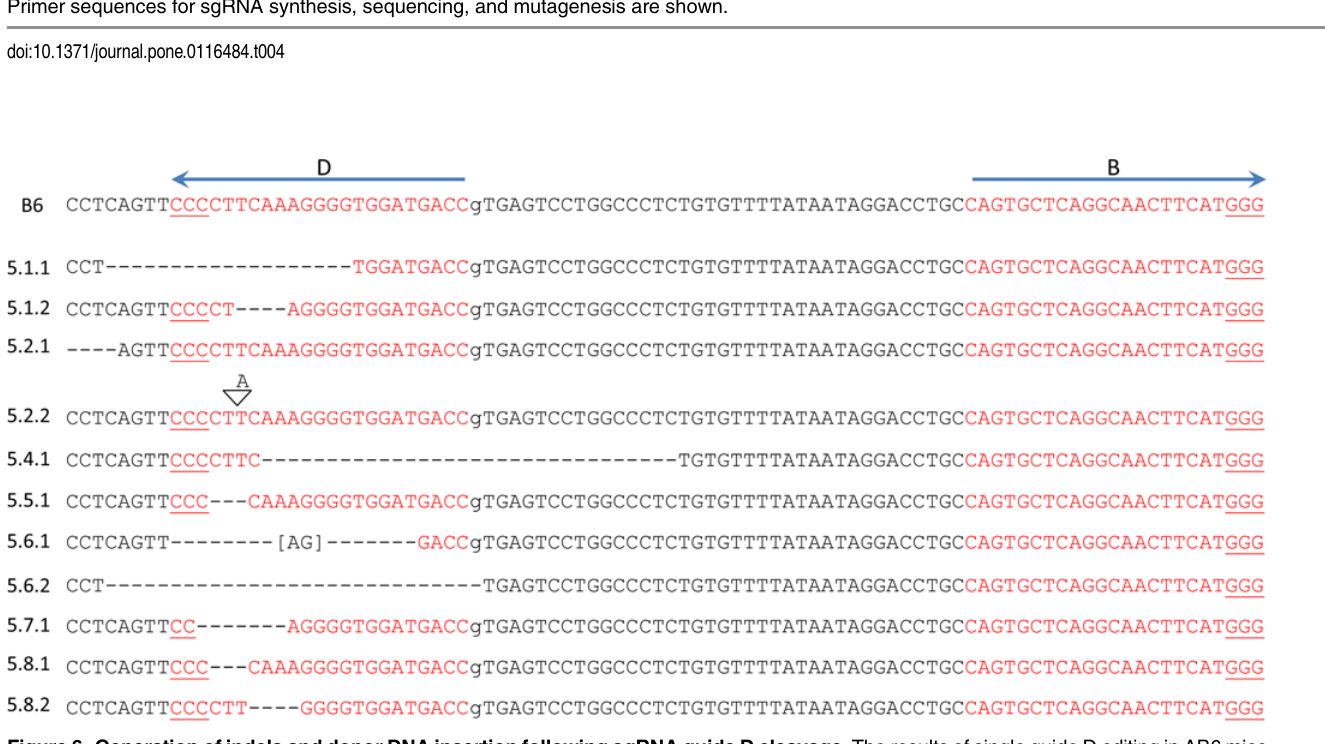
Figure 6. Generation of indels and donor DNA insertion following sgRNA guide D cleavage. The results of single guide D editing in AB6 mice (Experiment 5) with a donor template are depicted. Mice are numbered as in Fig. 2b. The B6 allele is indicated with the positions of guides B and D as in Fig. 1. Sequencing results from unaltered Tyr alleles are not shown (5.4.2, 5.5.2, 5.7.2). Deleted nt (-). Inserted nt in